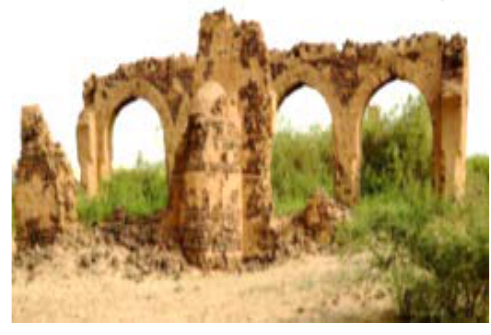
(Figure. 5) Ahmed bin Idriss Mosque in Jizan 14 th A.H/ 20 th